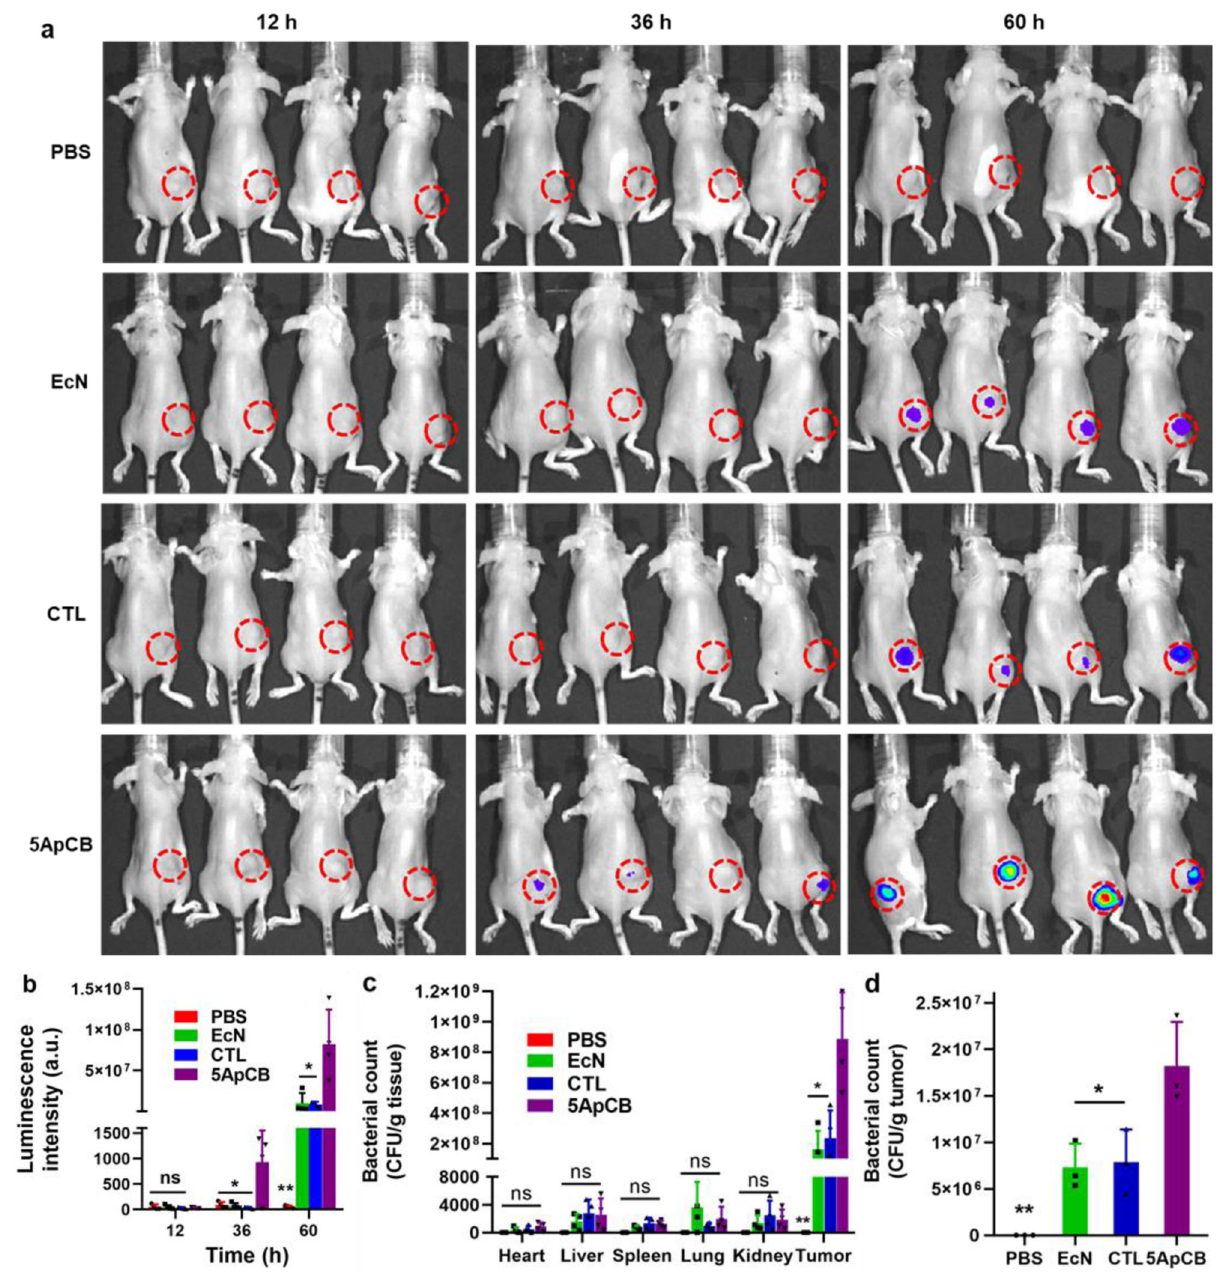
Fig. 4 Biodistribution of ApCB in tumor-bearing mice. a IVIS imaging of 4T1 tumor-bearing mice at 12, 36, and 60 h after tail vein injection with PBS or 1 × 10 7 CFU EcN Lux , CTL Lux , and 5ApCB Lux , respectively. b Average intensity of luminescence signals from the tumor site at 12, 36, and 60 h after injection. Luminescence intensity (atomic units, a.u.) was quanti fi ed by a Caliper IVIS Lumina II system using a region-of-interest drawn to encompass the entire solid tumor ( n = 4). Data are presented as mean values ± SD. Signi fi cance was assessed using Student ’ s t test (two-tailed), giving p values: 0.4115 for 5ApCB vs PBS, 0.5746 for 5ApCB vs EcN, 0.6742 for 5ApCB vs CTL at 12 h; 0.0370 for 5ApCB vs PBS, 0.0339 for 5ApCB vs EcN, 0.0287 for 5ApCB vs CTL at 36 h;0.0081 for 5ApCB vs PBS, 0.0131 for 5ApCB vs EcN, 0.0132 for 5ApCB vs CTL at 60 h. ns: no signi fi cance. c Biodistribution of bacteria in the major organs and tumor tissue of mice at 60 h after tail vein injection with PBS or 1 × 10 7 CFU of EcN, CTL, and 5ApCB, respectively. Numbers of bacteria were quanti fi ed by plate counting. Data are presented as mean values ± SD ( n = 4). Signi fi cance was assessed using Student ’ s t test (two-tailed), giving p values: 0.0739 for 5ApCB vs PBS, 0.1990 for 5ApCB vs EcN, 0.1831 for 5ApCB vs CTL in heart; 0.1165 for 5ApCB vs PBS, 0.3731 for 5ApCB vs EcN, 0.9173 for 5ApCB vs CTL in liver; 0.0536 for 5ApCB vs PBS, 0.2886 for 5ApCB vs EcN, 0.8260 for 5ApCB vs CTL in spleen; 0.1069 for 5ApCB vs PBS, 0.4269 for 5ApCB vs EcN, 0.3103 for 5ApCB vs CTL in lung; 0.2162 for 5ApCB vs PBS, 0.8439 for 5ApCB vs EcN, 0.5253 for 5ApCB vs CTL in kidney; 0.0012 for 5ApCB vs PBS, 0.0138 for 5ApCB vs EcN, 0.0108 for 5ApCB vs CTL in tumor. ns: no signi fi cance. d Numbers of EcN colonized within the tumor at 12 h after injection. Error bars represent the standard deviation ( n = 3). Data are presented as mean values ± SD. Signi fi cance was assessed using Student ’ s t test (two-tailed), giving p values: 0.0027 for 5ApCB vs PBS, 0.0251 for 5ApCB vs EcN, 0.0390 for 5ApCB vs CTL. * p < 0.05, ** p < 0.01. Source data are provided as a Source Data fi le.